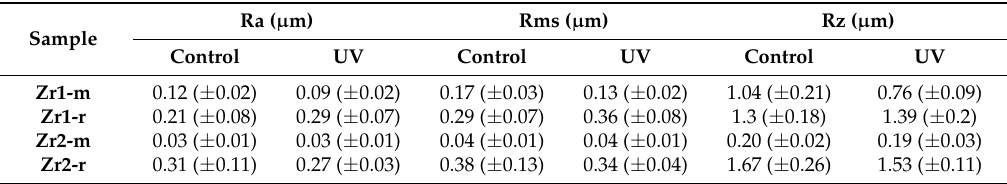
Table 1. Surface roughness values of different groups measured by AFM. No significant changes were observed in Ra, Rz or Rms values after UV treatment of zirconia samples.